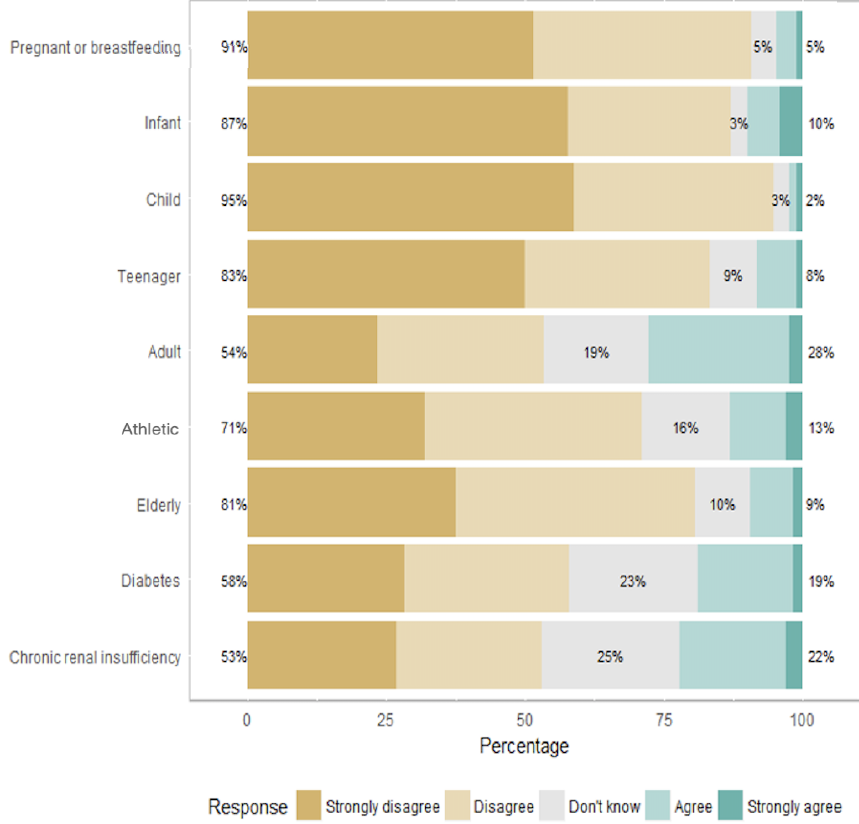
Figure 4. Vegan diet’s suitability, depending on different populations.